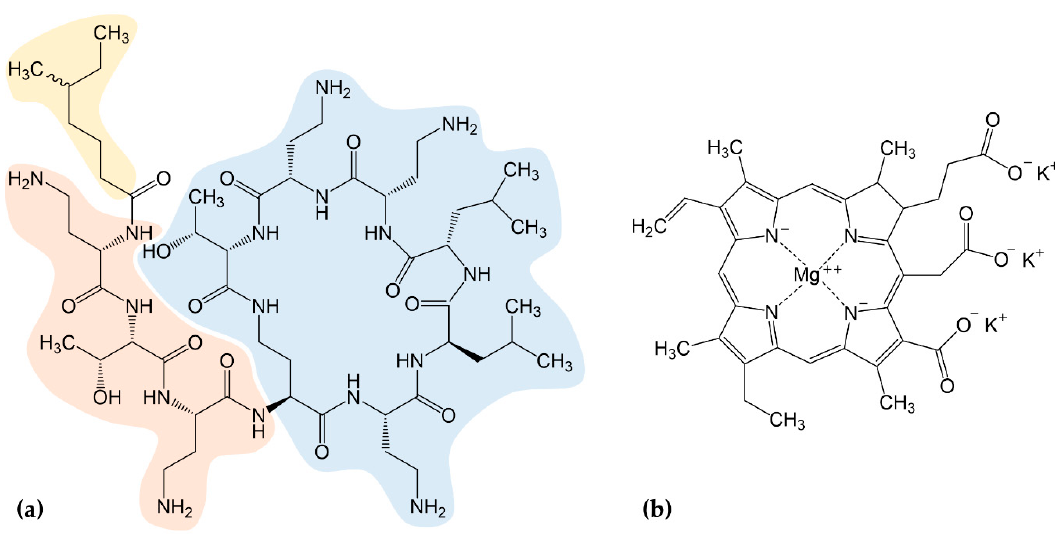
Figure 1. ( a ) The chemical structure of colistin is composed of three parts: a hydrophobic fatty-acyl tail (yellow), a linear tripeptide segment (orange), and a hydrophilic, heptapeptide ring (blue); ( b ) Chemical structure of chlorophyllin. A combination of both components was used to control Gram-negative bacteria.